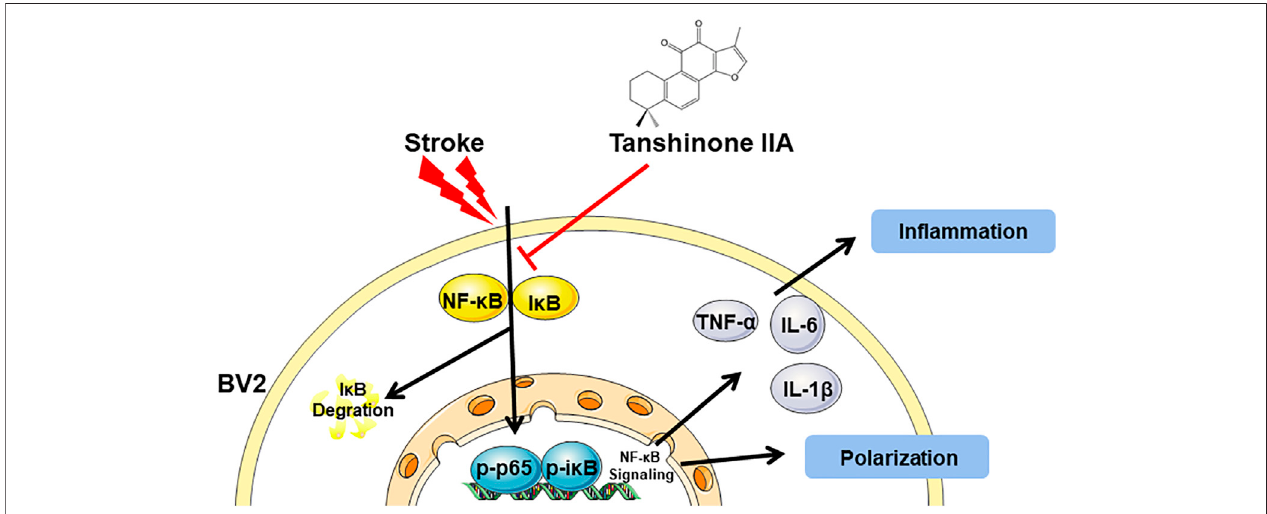
FIGURE 8 | A graphical representation of the neuroprotective mechanisms of Tanshinone IIA against the stroke-induced neuroin fl ammation by NF- κ B signaling